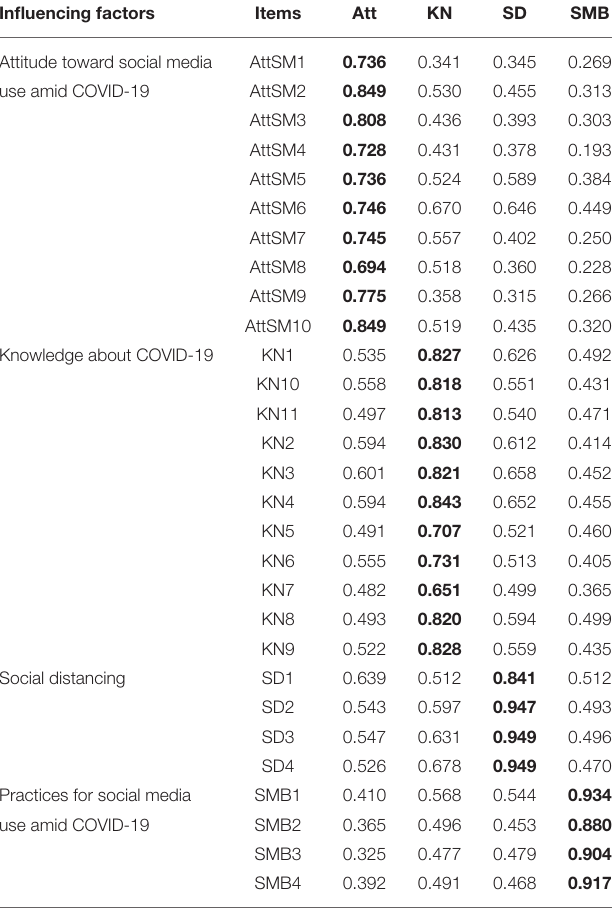
TABLE 4 | Cross-loadings of the items based on the study variables. Influencing factors